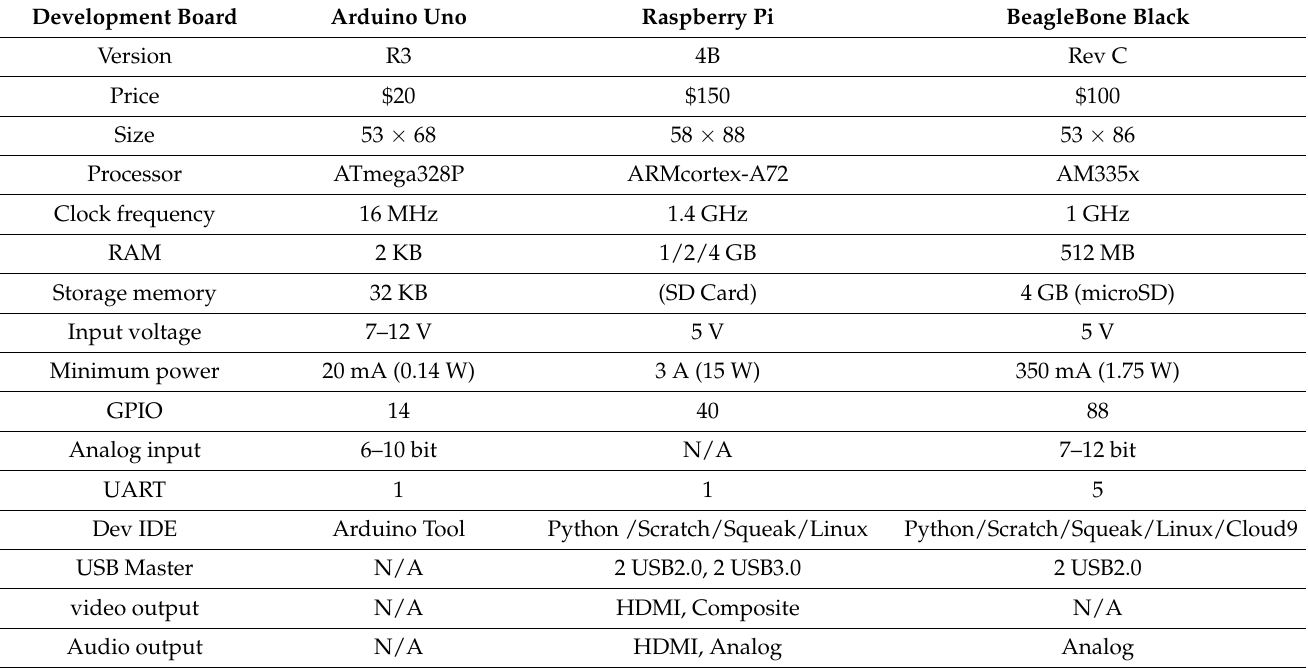
Table 1. Development board parameters